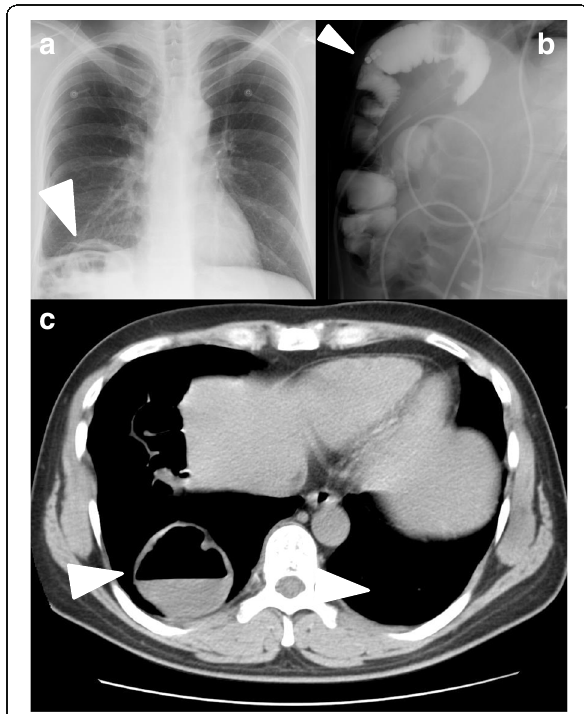
Fig. 1 Preoperative examinations. Chest and abdominal plain radiographic findings. a The chest radiograph revealed intestinal air in the right lower lung field (arrow head). b The abdominal radiograph revealed dilation of the large intestine with gas (arrow head). c Computed tomography showing the herniated transverse colon located in the right thoracic cavity (arrow